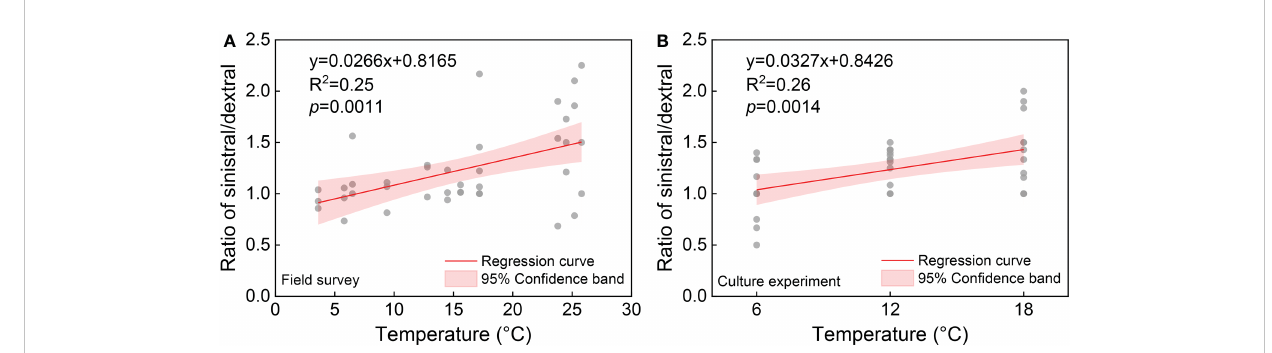
FIGURE 3 The relationship between ratio of sinistral/dextral and temperature from fi eld survey (A) and culture experiment (B) .